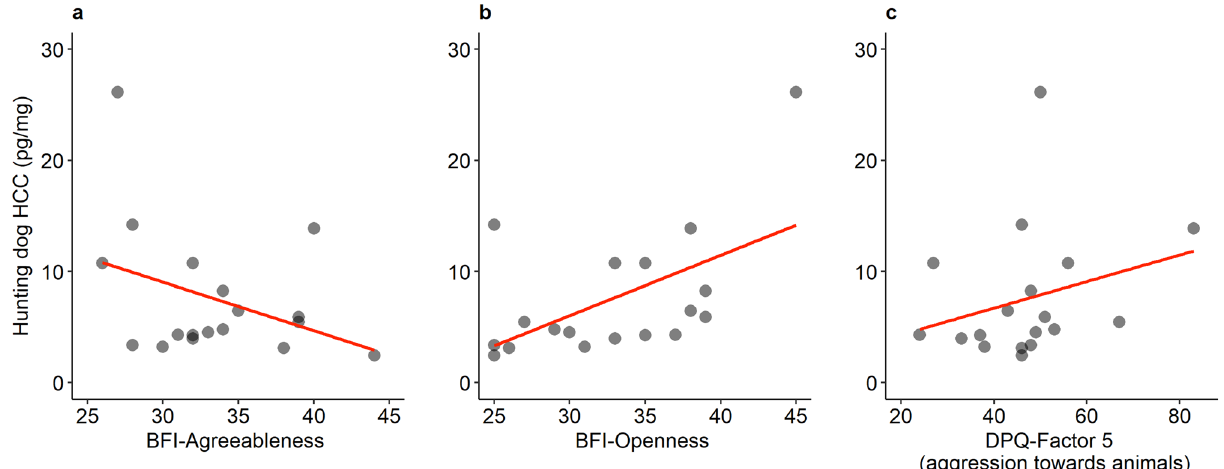
Figure 1. Correlations with fitted lines between dog HCC (pg/mg) of solitary hunting breeds’ and the human personality trait BFI-Agreeableness ( a ), BFI-Openness ( b ) and the dog personality trait DPQ Factor5- Aggression towards animals ( c ). This image was created using R version 4.0.4. https:// www.R- proje ct. org and package ggplot2 https:// ggplo t2. tidyv erse.